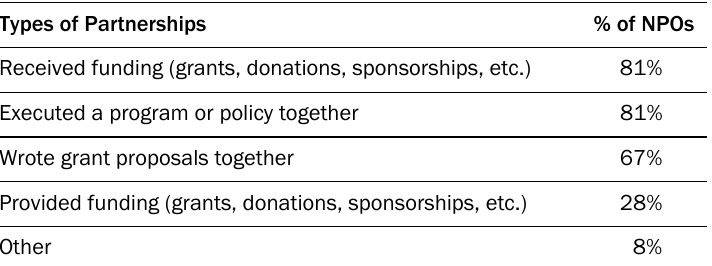
Table 5. Types of Interorganizational Partnerships Types of Partnerships